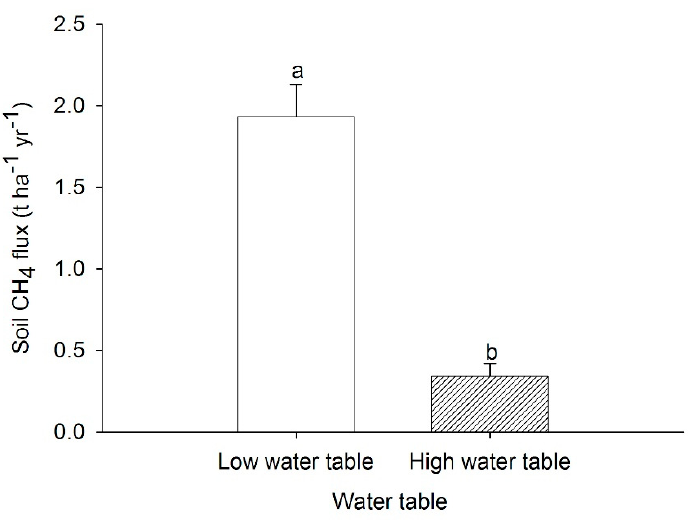
Figure 10. Averaged soil CH 4 emissions over 24 h from a peat soil grown with pineapple in lysimeters under low and high water table. Error bars represent standard error and soil mean fluxes with different letters are significantly different using DNMRT at p ≤ 0.05.